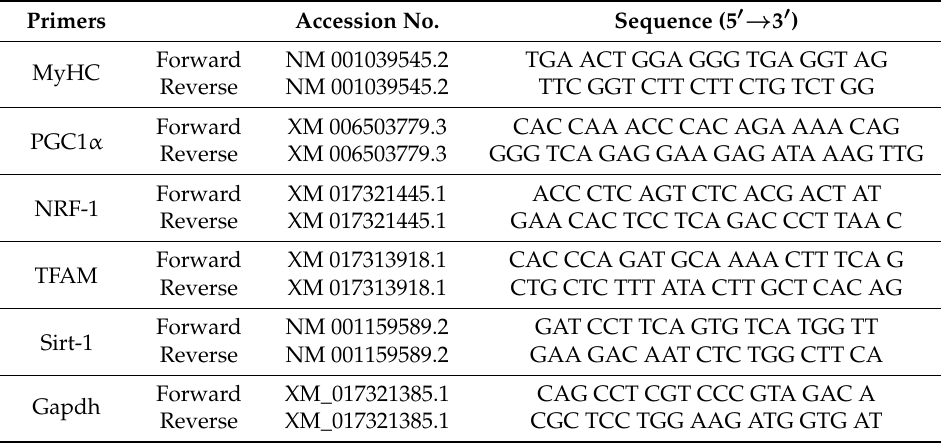
Table 1. Primer sequences of the target genes for